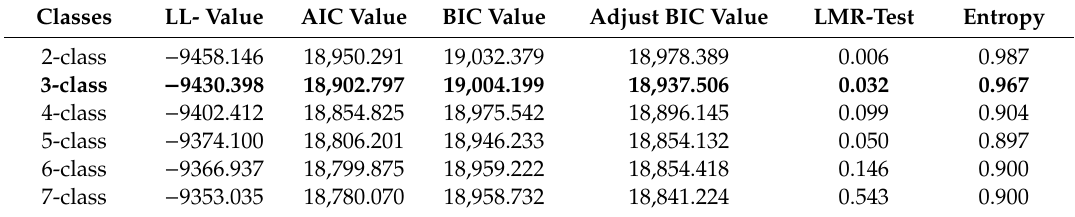
Table 4. Fit indices for one- to seven-class growth mixture models for maternal